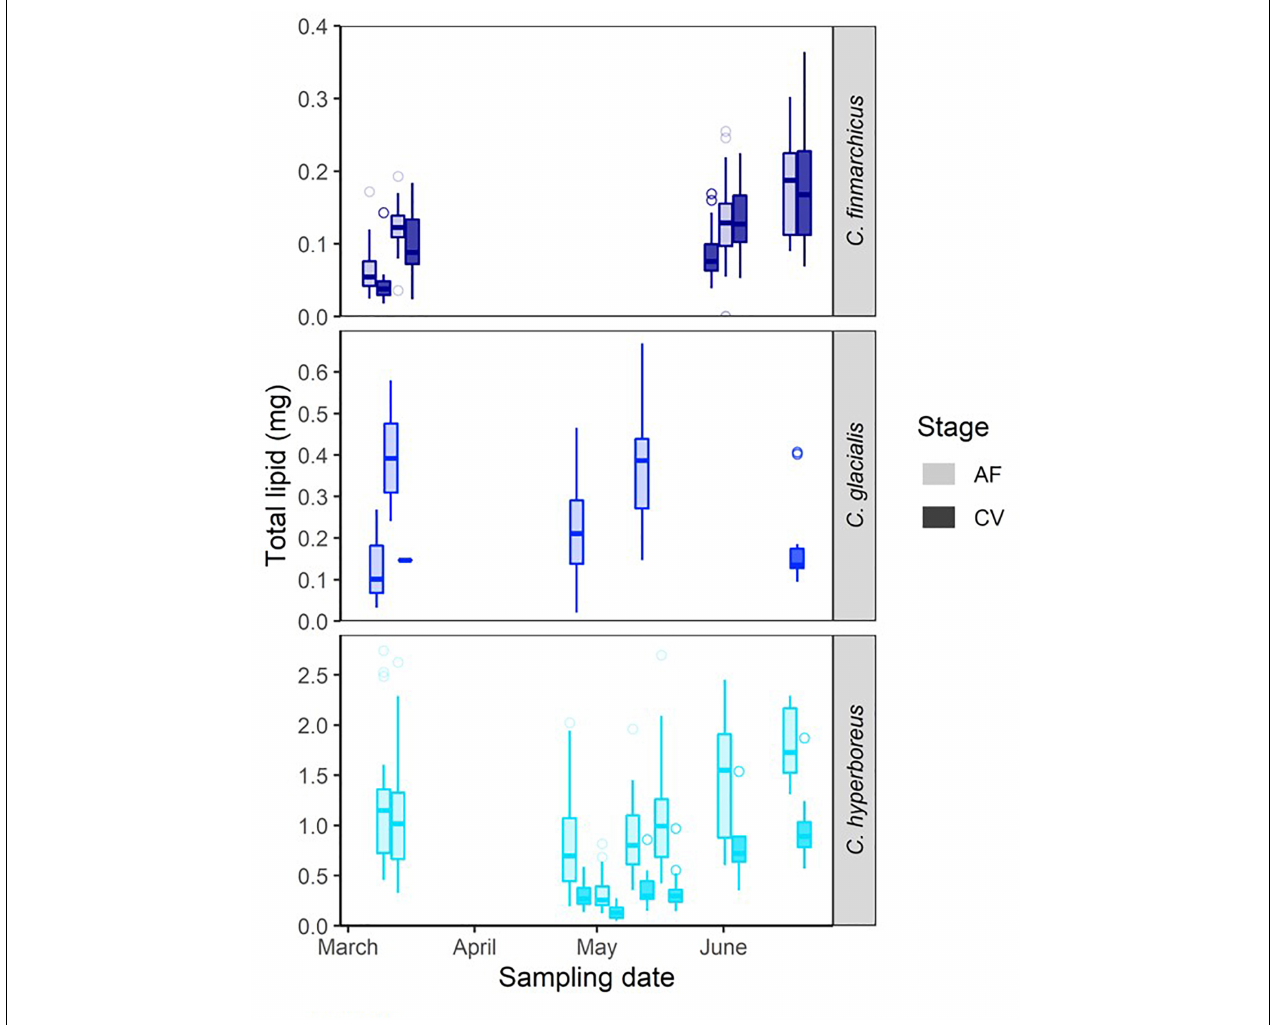
FIGURE 6 | Total lipid in stage CV and AF (adult females) of three Calanus species over time, collected from the upper water column along the drifts (bottom depth of collection tow varies between 600 and 50 m). Boxplots present the following data: rectangle extent indicates the interquartile range (IQR), the 25 and 75% percentile, the middle line indicates the 50% quantile (the median), the whisker length extends to the last value within 1.5*IQR, and outlier points beyond this are indicated as